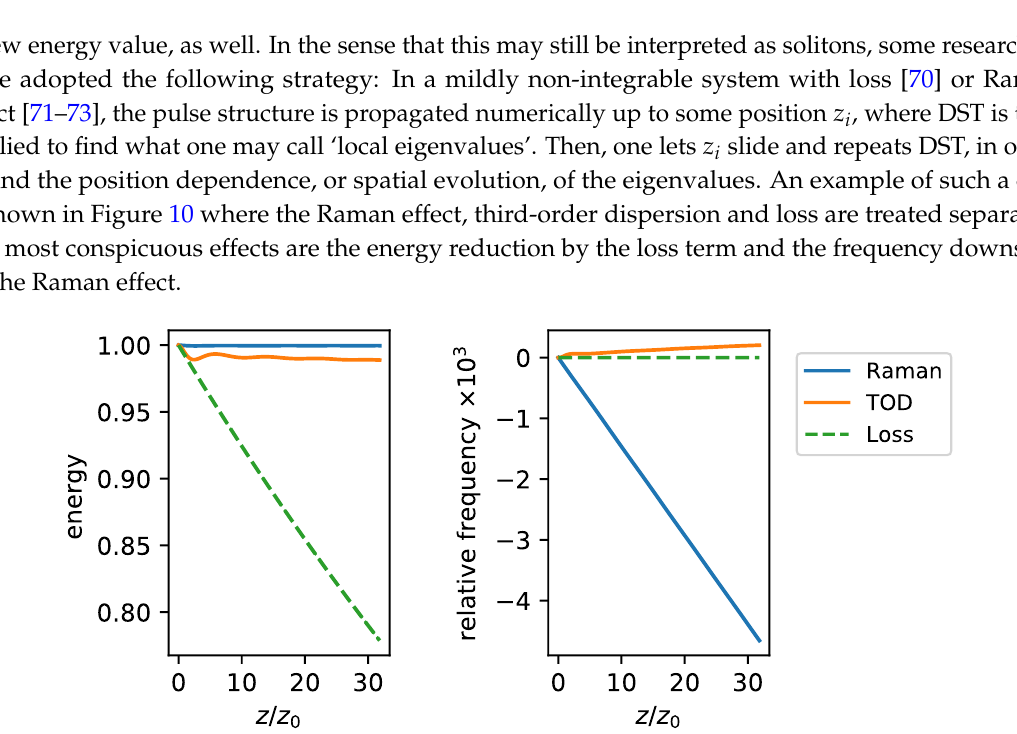
Figure 10. Energy and frequency eigenvalues of a fundamental soliton obtained using the DST method. The soliton was perturbed by Raman self-frequency shift (blue, solid, Raman response time: T R = 0.03 T 0 ), third-order dispersion (orange, solid, TODparameter: β 3 = 0.5 T 0 β 2 ), and linear loss (green, dashed, loss length: L α = 200 L D